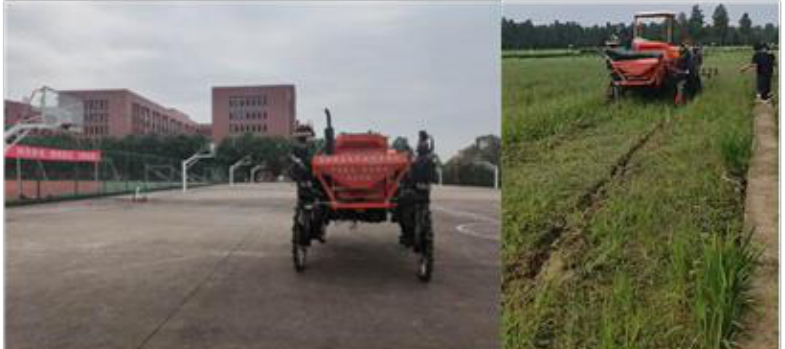
Figure 5. Test environments (( Left ), cement ground; ( Right ), subsiding paddy field).